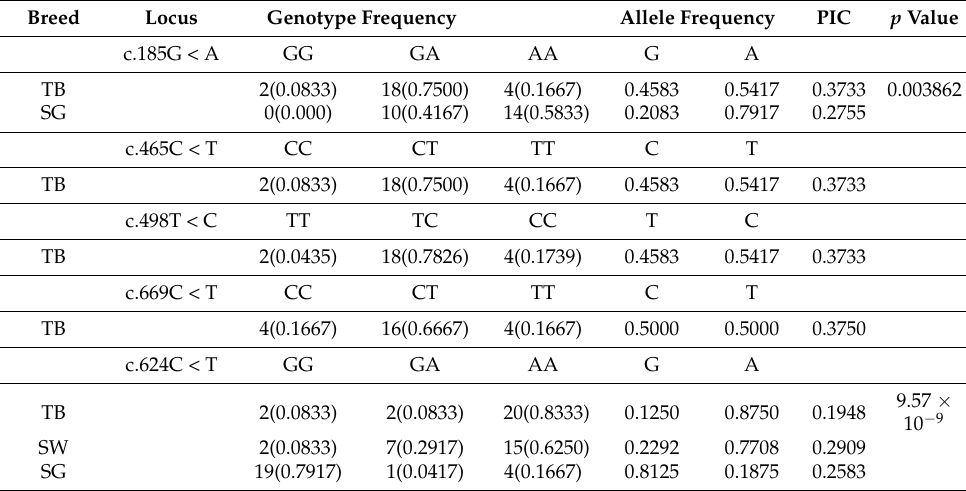
Table 4. Allelic and genotypic distribution of the TYR gene in four rabbit breeds. Breed